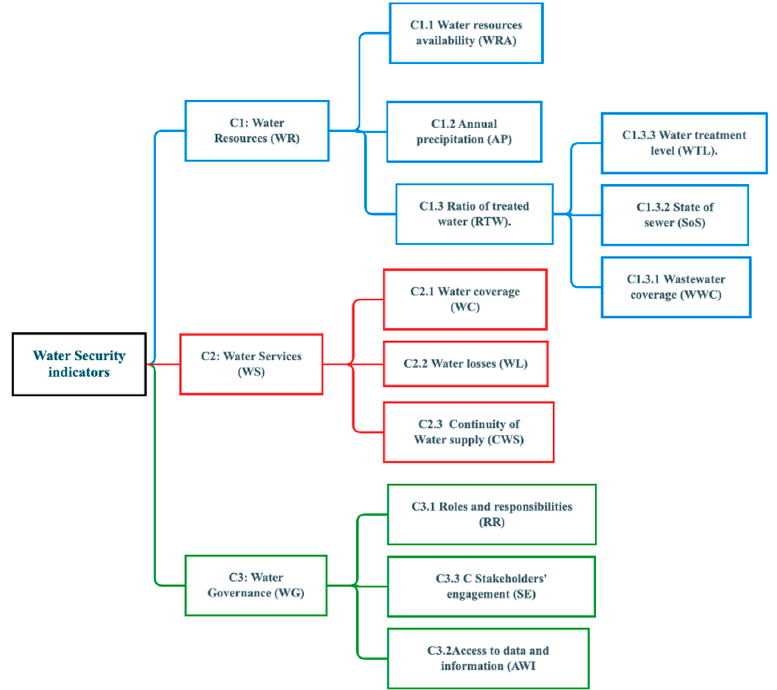
Figure 1. Set of indicators used in the assessment of water security in Palestinian cites.